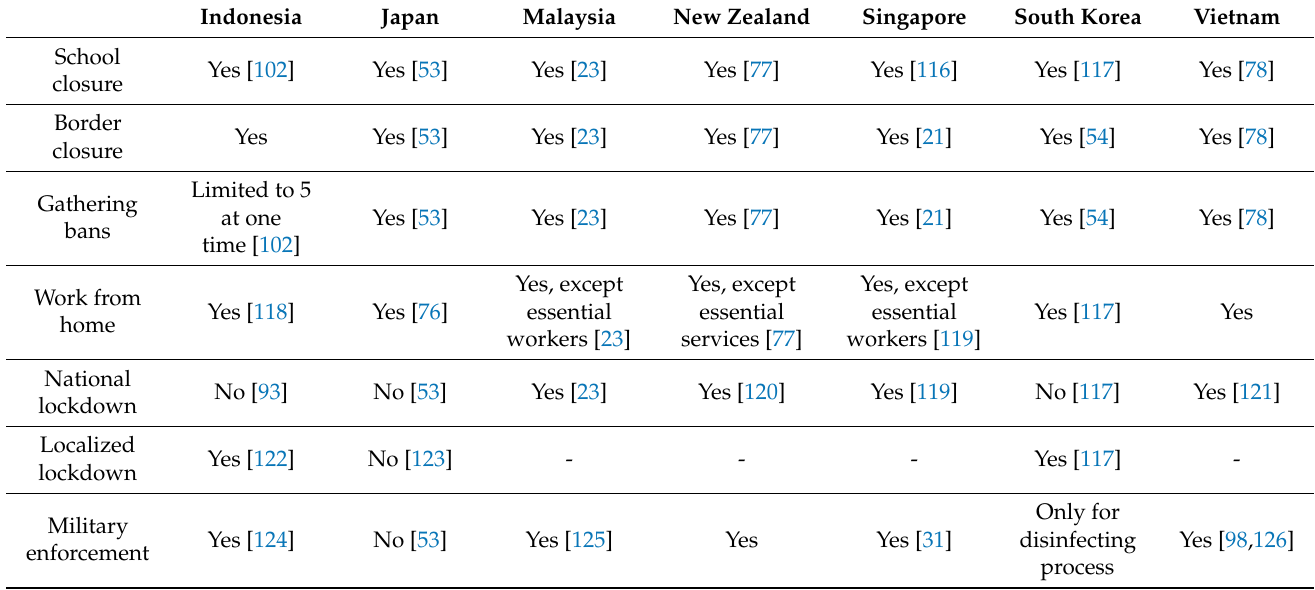
Table 13. Lockdown enforcement of each